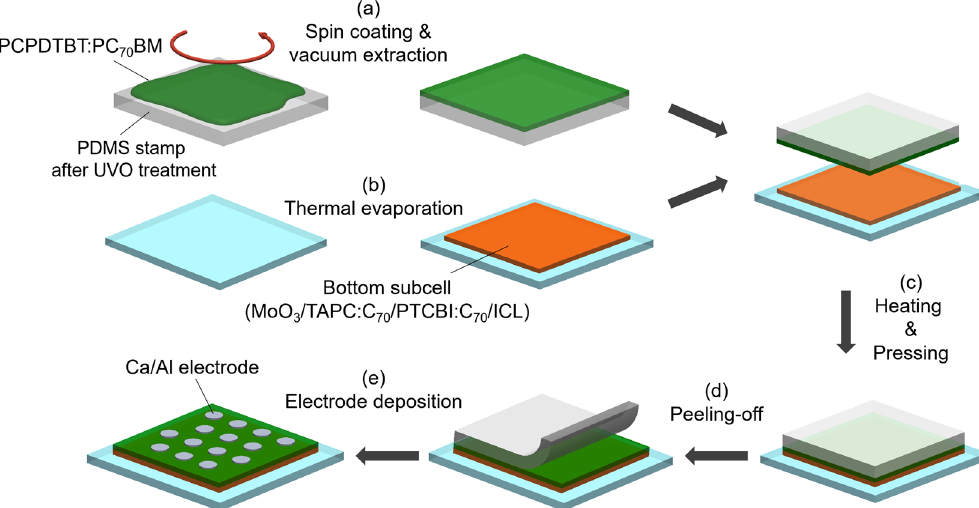
Figure 2. Schematic illustration of fabrication of hybrid organic tandem solar cells by the thin-film transfer technique. ( a ) Spin-coating of a PCPDTBT:PC 70 BM solution on a PDMS stamp and removal of a solvent and an additive. ( b ) Bottom subcell deposition on an ITO-coated glass substrate by thermal evaporation in vacuum. ( c ) Pressing of the stamp on the substrate with mild heating. ( d ) Peeling off the PDMS stamp from the substrate. ( e ) Deposition of the top electrodes.